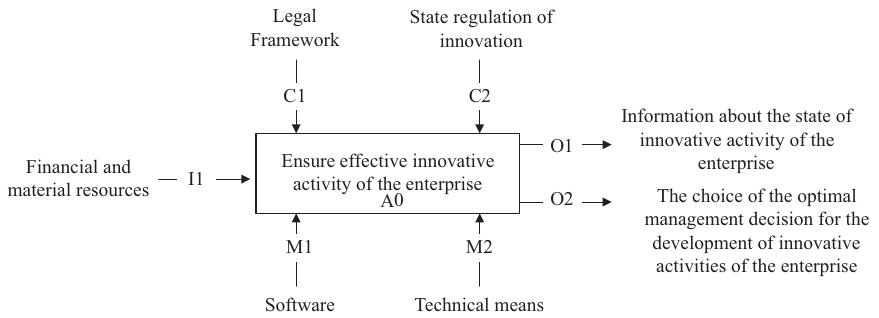
Figure 2. Application of the “Black Box” method for better display of input and initial information on the formation of a functional